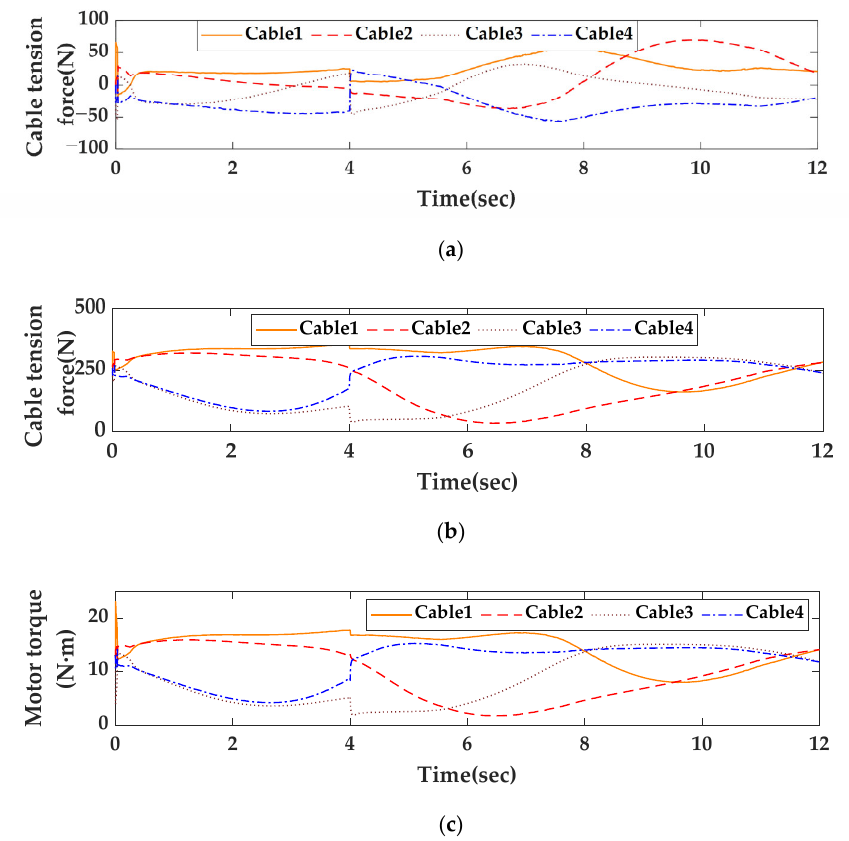
Figure 12. ( a ) Cable tension not optimized; ( b ) cable tension value after optimization; ( c ) motor torque.